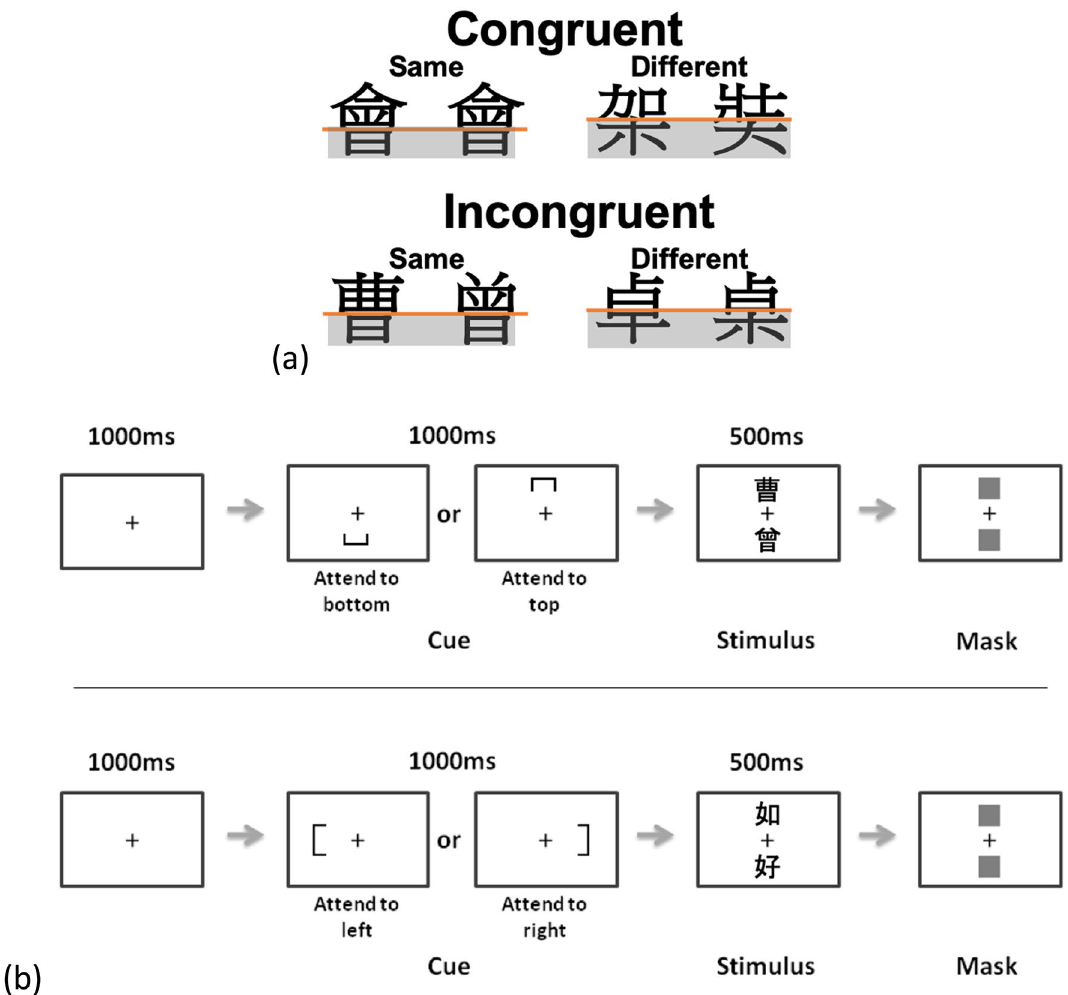
Figure 5. Illustration of stimulus pairs in the complete composite paradigm ( a ) and trial sequences ( b ). In ( a ), the four conditions used in the paradigm are shown; the attended components are shaded in grey. In ( b ), a 1000 ms central fixation cross precedes each trial, followed by a cue either below or above the cross, or to the left or right of it, to indicate which halves (top or bottom/left or right) of the characters the participant should attend to in the subsequent display.